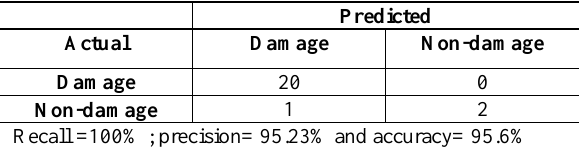
Table 2. Results of classification of missing 3D segments detected by segment-based approach